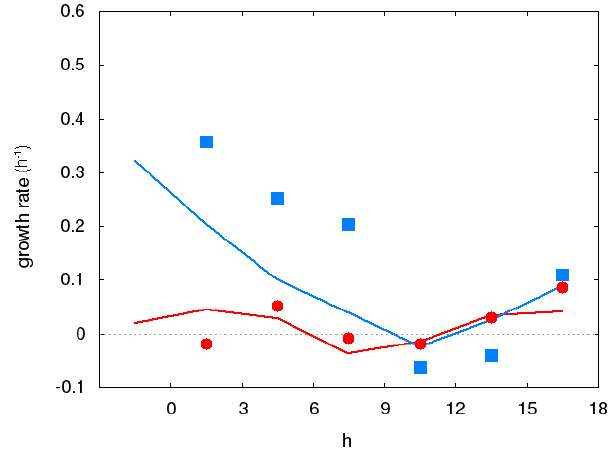
Figure 3. Growth rates of forecast errors for the two control trajec- tories of Fig. 1 and the corresponding leading bred vector. Times indicated on the x axis correspond to UTC times on 26 Septem- ber 2006. Breeding parameters: period 30min, amplitude 0.36 (red dots) for trajectory 18H (large initial error, red line); period 15min, amplitude 0.100 (blue squares) for trajectory R21 (small initial er- ror, blue line).